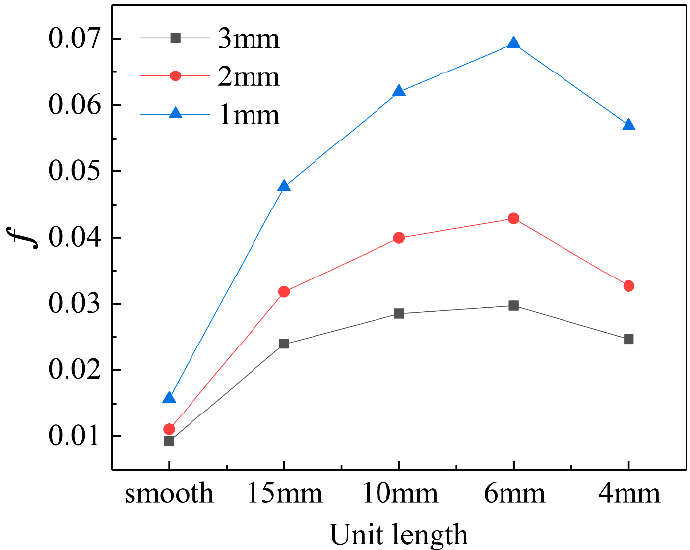
Figure 11. Variation friction factor of the groove section with different